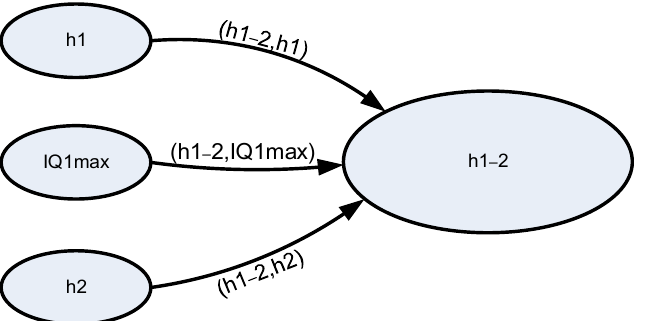
Figure 6. Model for intermediate hypotheses h1–2 (IQ1max is the maximum value which can be achieved by the factor of the hypothesis [32]).